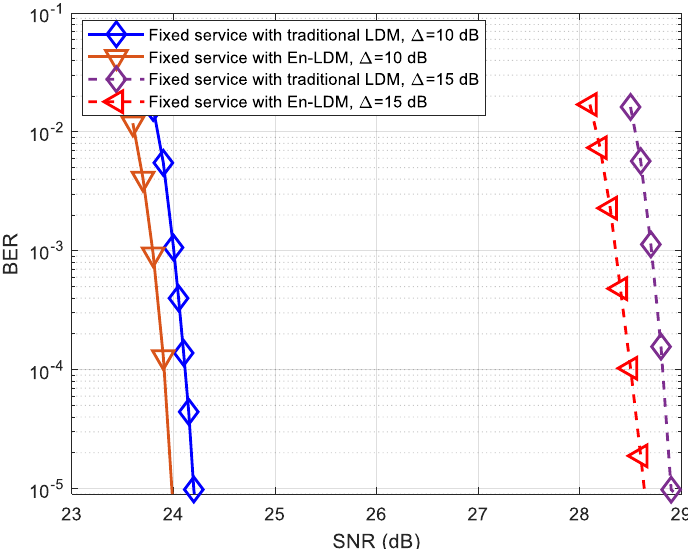
Figure 9. BER performance of fixed service with En-LDM and traditional LDM systems under the AWGN channel, where the injection levels were set to ∆ = 10 and 15 dB, the CL constellation was set to QPSK, the EL constellation was set to NU − 64QAM, the puncturing rate of the En-LDM scheme was set to 1/13, and the LDPC code rates of CL and EL were set to 5/15 and 11/15, respectively.